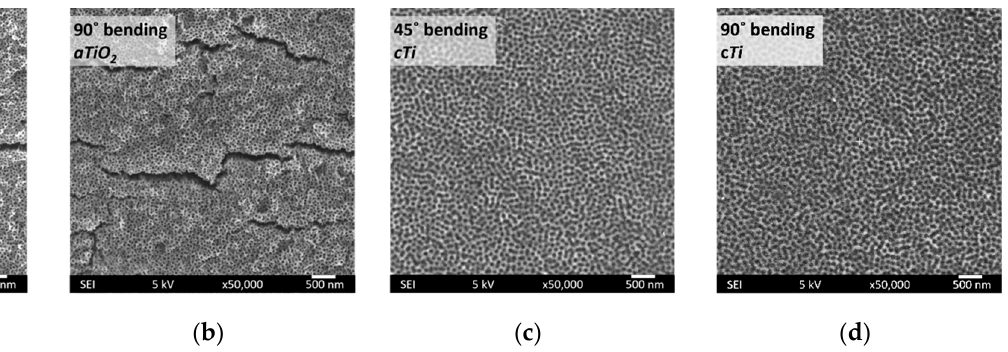
Figure 6. SEM images of the surface after the three ‐ point bending tests: ( a ) 45° bending of aTiO 2 , ( b ) 90° bending of aTiO 2 , ( c ) 45° bending of cTi , and ( d ) 90° bending of cTi.